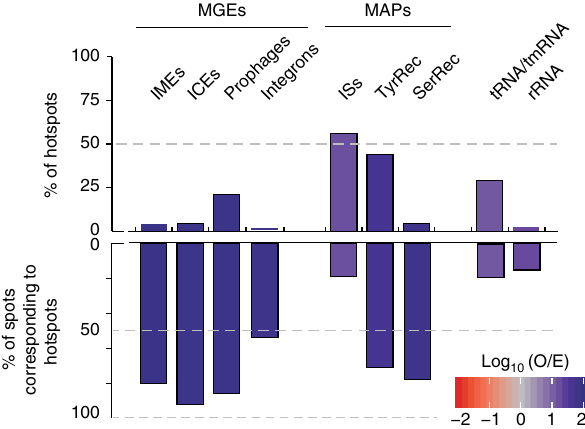
Fig. 5 Genetic mobility of hotspots. We represent the percentage of hotspots containing the different genetic elements ( top ) and the percentage of spots containing such elements that are hotspots ( bottom ). Note that hotspots are only 1.2% of all the spots. The analysis includes MGEs (IMEs, ICEs, prophages, integrons), mobility-associated proteins (MAPs) (ISs, TyrRec, SerRec), and tRNA/tmRNA, rRNA. Also, shown in colored bins are the observed/expected (log 10 O/E) number of hotspots that contain the abovementioned elements, when the null model was computed from the distribution of coldspots containing the same type of elements. Expected values were obtained by multiplying the number of hotspots by the fraction of spots containing each type of resistance genes (ARGs), which is much more than expected by chance (0.8%) (Fig. 4b).